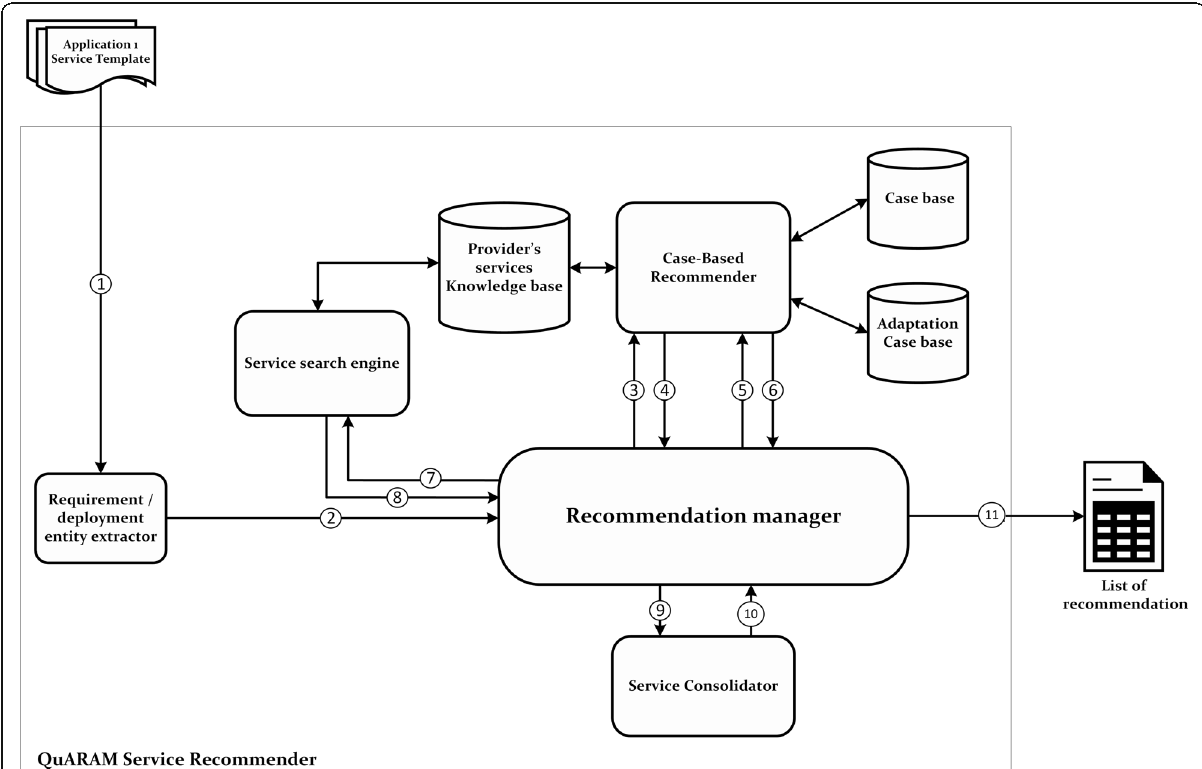
Fig. 5 QuARAM Service Recommender sequence